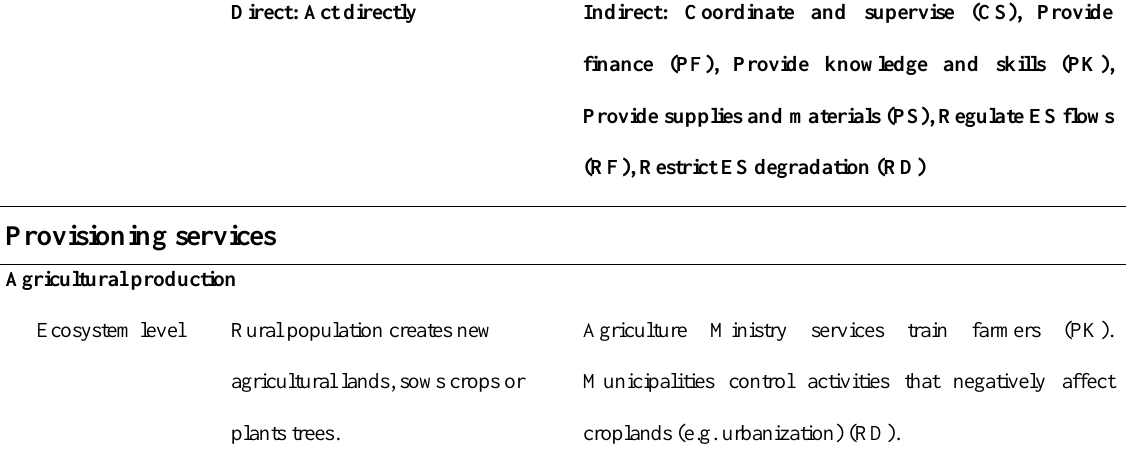
Table A4.1. Examples of management activities for each of the eight selected ES. This list is not exhaustive, but rather